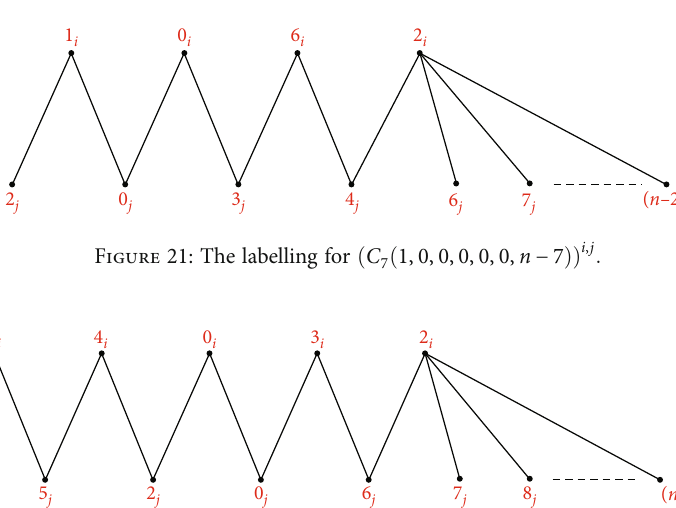
Figure 22: The labelling for ð C